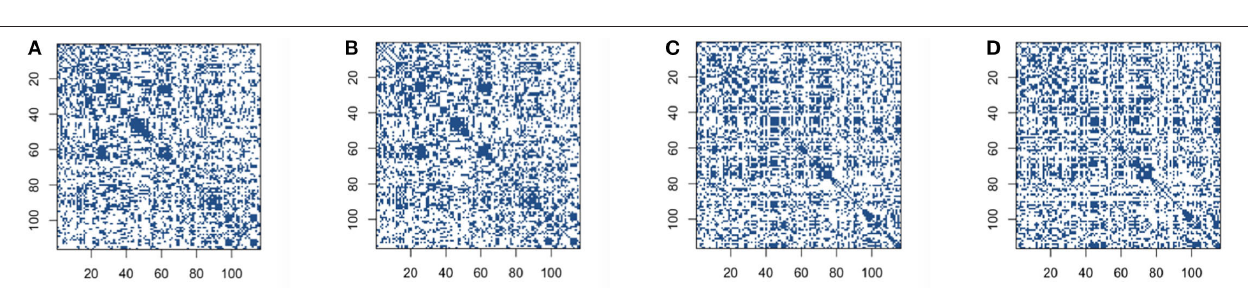
FIGURE 3 | Connectivity selection results for control and Alzheimer’s disease (AD) group from sparse covariance estimation method: (A) control group based on original blood oxygen level dependent (BOLD) signals; (B) control group based on low-rank matrix; (C) AD group based on original BOLD signals; (D) AD group based on low-rank